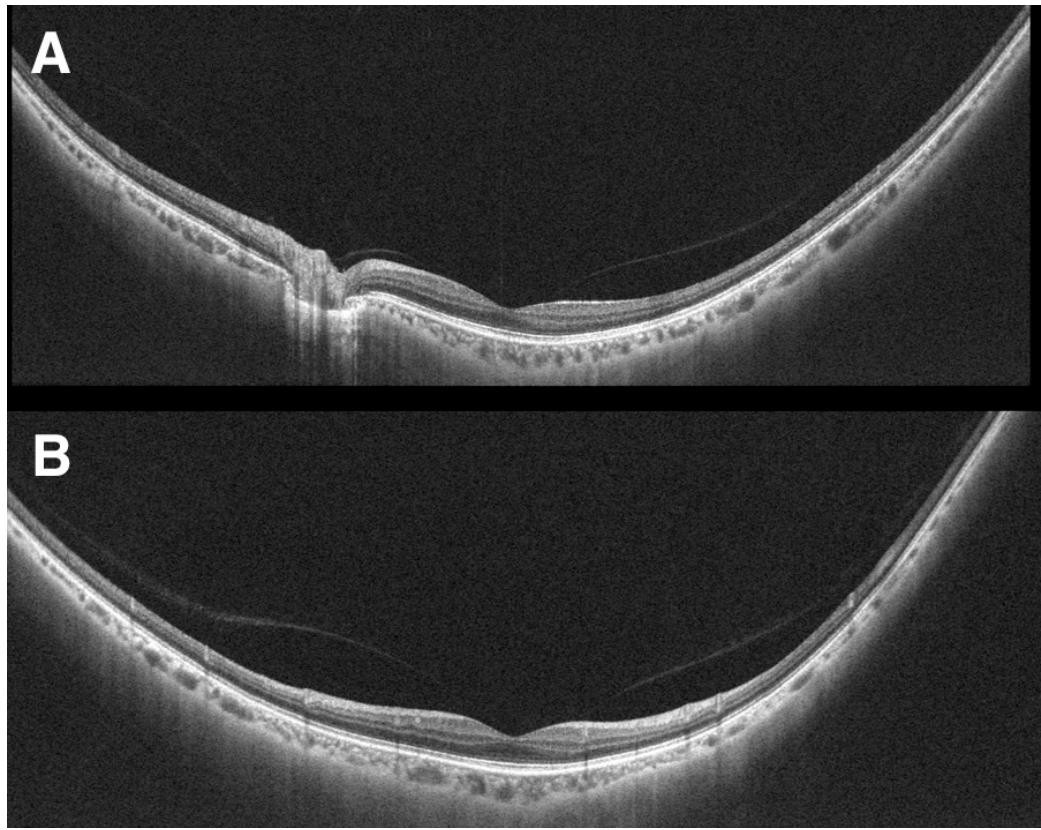
Figure 6. Ultrawide-field optical coherence tomography (UWF-OCT) Image. ( A ) Horizonal scan image (23 mm in length). ( B ) showcases vertical scan (20 mm in length). Reprinted with permission from Takahashi et al. [28]. Ultra-Widefield Optical Coherence Tomographic Imaging of Posterior Vitreous in Eyes With High Myopia. Am J Ophthalmol. 2019;206:102-12. with license permissions obtained from Elsevier and Copyright Clearance Center.